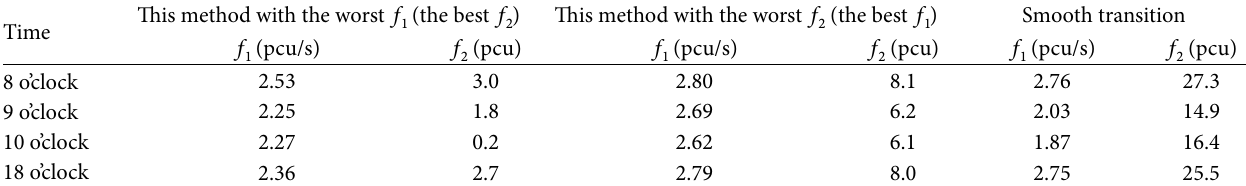
Table 5: Simulation results of smooth transitioning control